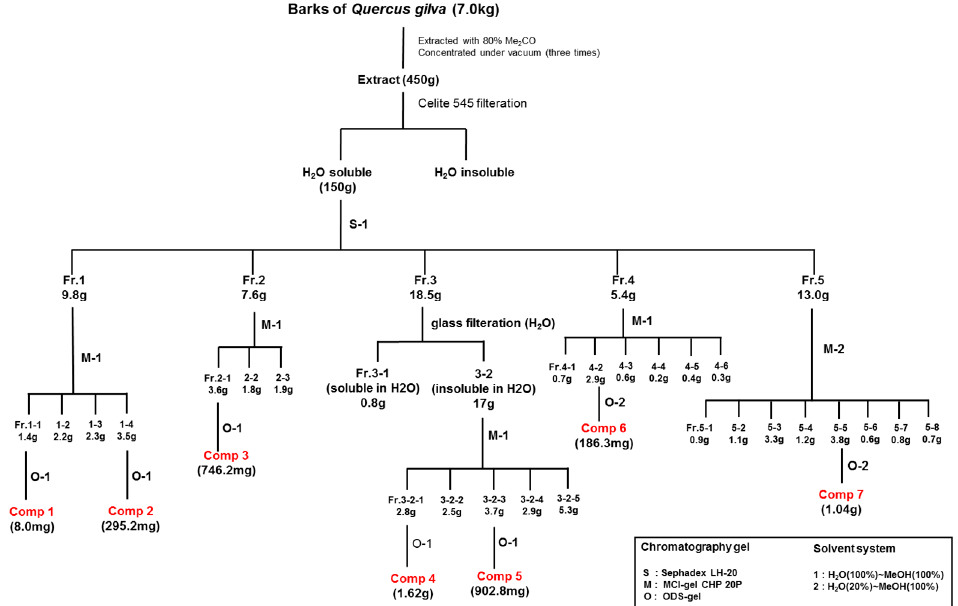
Figure 4. Extraction and separation processes of active compounds from bark of Quercus gilva Blume.